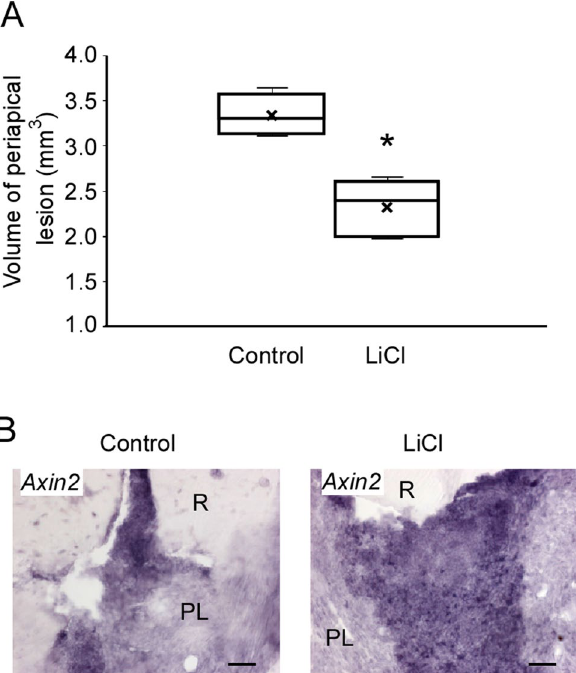
Figure 5. Activation of the Wnt/β-catenin signaling pathway reduced the periapical lesion volume. ( A ) Quantification of periapical lesion volumes of the control group (white bar, mean ± SD, n = 4) and the LiCl application group (black bar, mean ± SD, n = 4). Two-tailed paired Student’s t test, * P < 0.05. ( B ) In situ hybridization for Axin2 in the periapical lesion at 4 weeks after chamber opening. R root, PL periapical lesion. Scale bars = 50